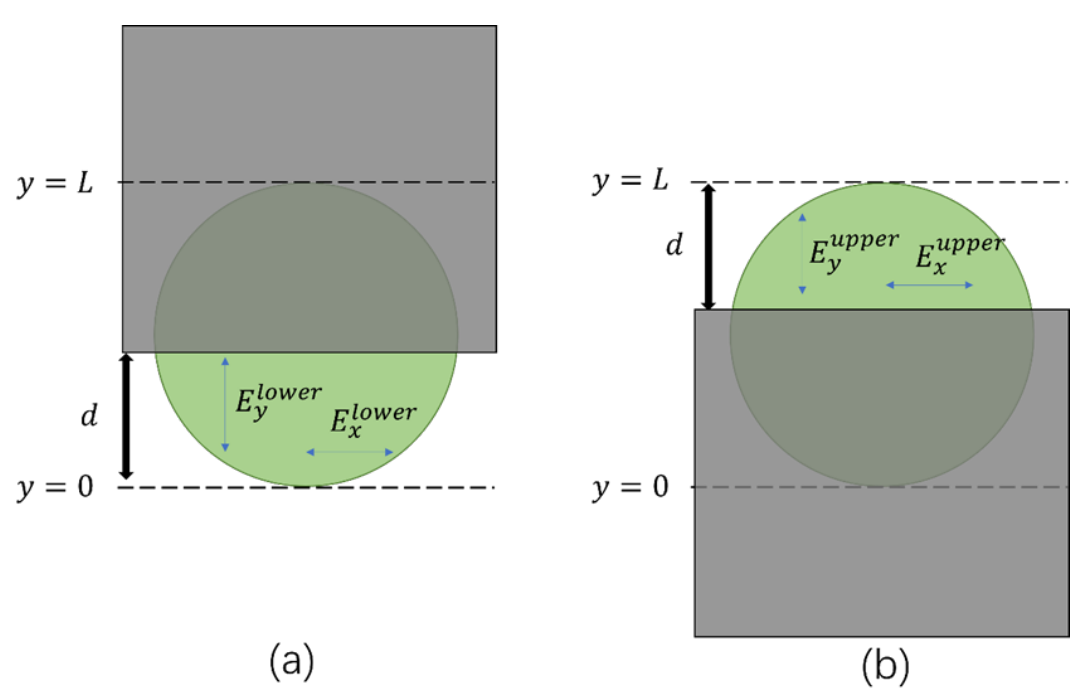
Figure 3. Determination the boundary of the THz beam pattern by moving a metal mask upwards ( a ), and downwards ( b ).